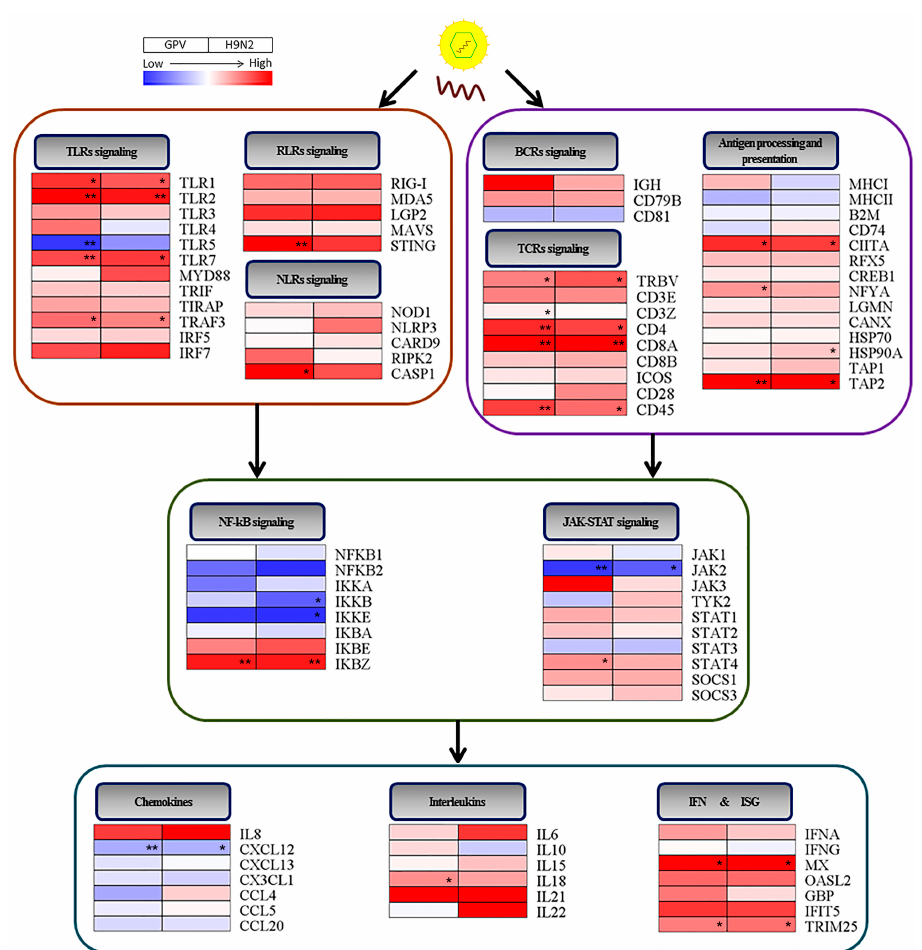
Figure 5. Comprehensive analysis of immune gene expression patterns after GPV and H9N2 infection. Four sections—PRR signaling pathways in the innate immune response, capture and display of the microbial antigen process in the adaptive immune response, cascade amplification signaling pathways, and cytokines/ISGs—were summarized. Among these pathways, genes that play pivotal roles in TLRs, RLRs, and NLRs signaling, as well as genes that encode interleukins, interferons, and ISGs were activated after viral infection. While, the genes associated with the activation of NF- κ B signaling were depressed. The two grids in each line represent the GPV and H9N2 group, respectively. The colors in the grid represent the expression fold change as indicated in the color scale. The special fold-changes of these immune genes and p -value were listed in Table S5. * p ≤ 0.05, ** p ≤ 0.01.